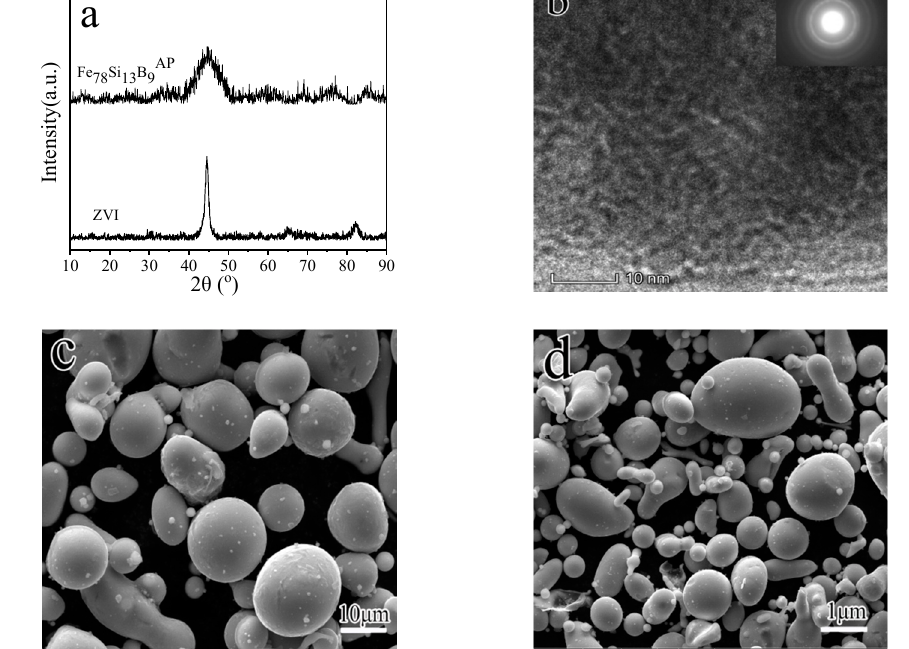
Figure 1. XRD spectra and SEM of the iron-based materials: ( a ) The XRD patterns; ( b ) the TEM image of Fe 78 Si 9 B 13AP ; ( c ) the surface morphology of Fe 78 Si 9 B 13AP ; ( d ) the surface morphology of zero valent iron (ZVI).